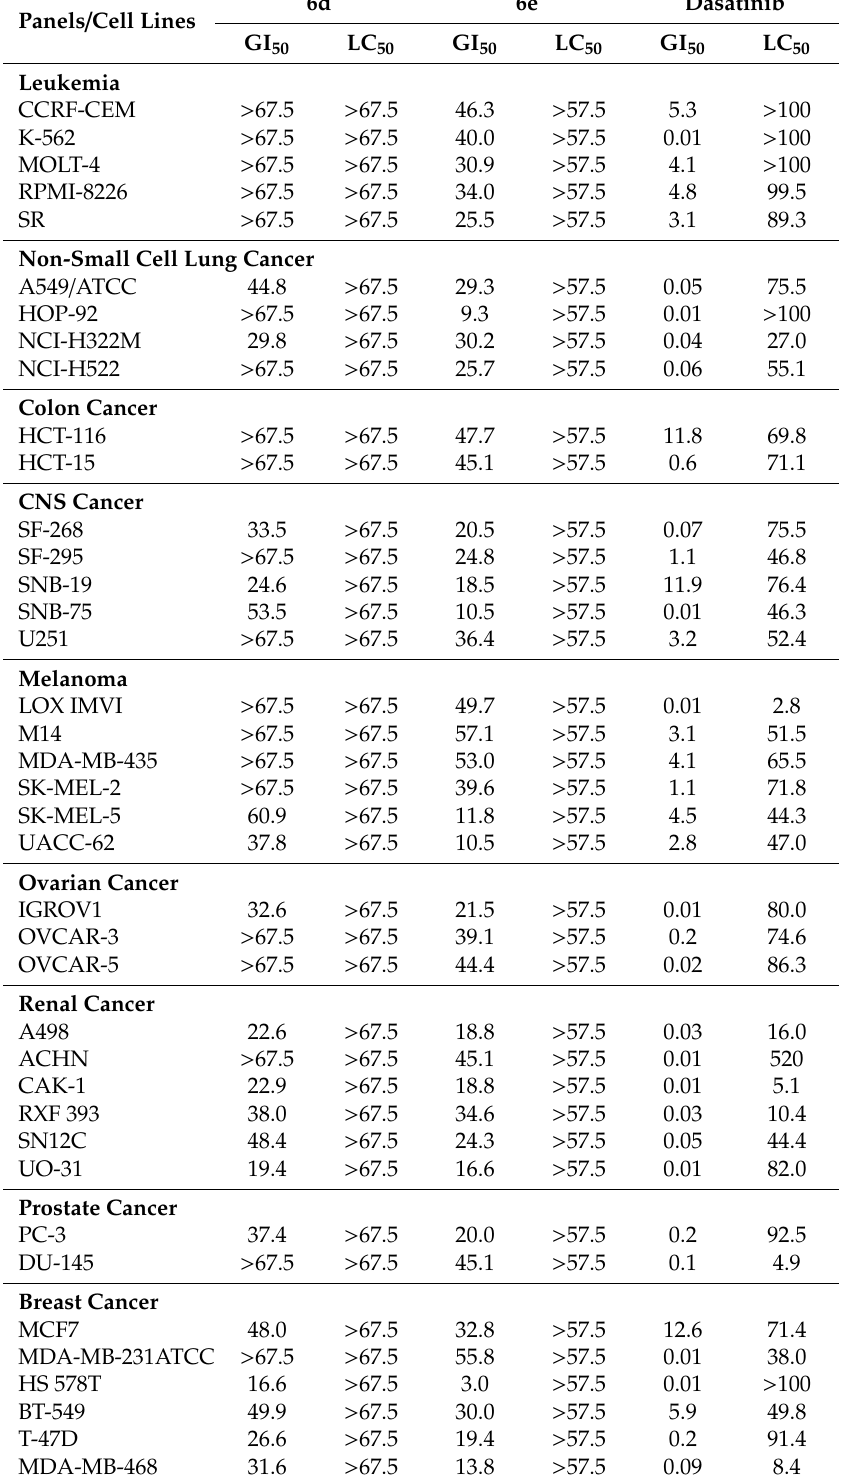
Table 5. Antitumor activity (GI 50 / µ M) a and toxicity (LC 50 / µ M) b data of 6d and 6e with the anticancer drug dasatinib as a positive